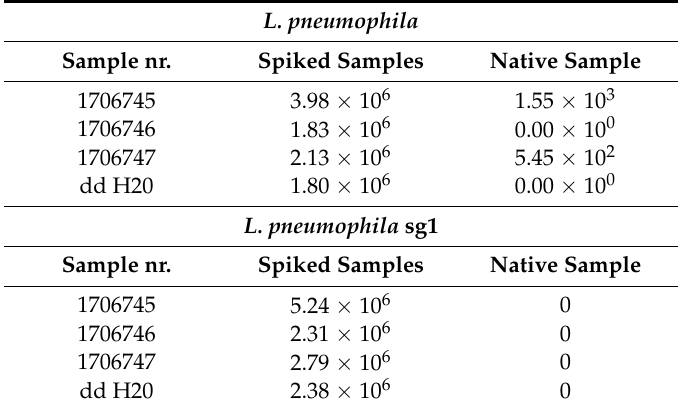
Table 4. DNA extraction efficacy and amplification inhibition control, values given in GU/100